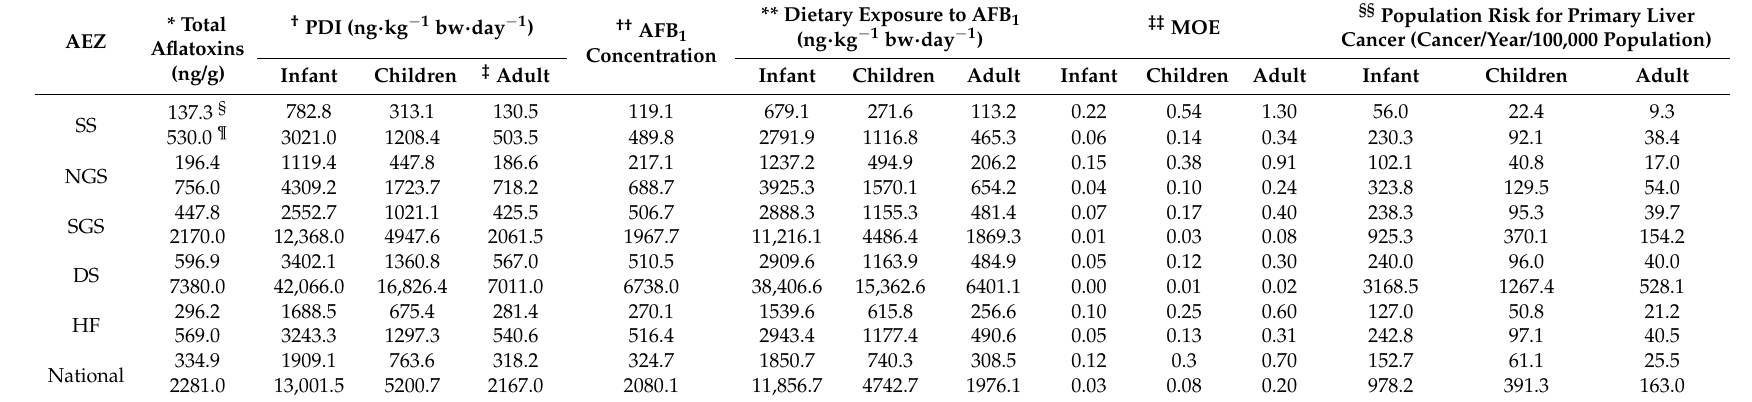
Table 1. Exposure assessment and estimated liver cancer risk due to consumption of maize